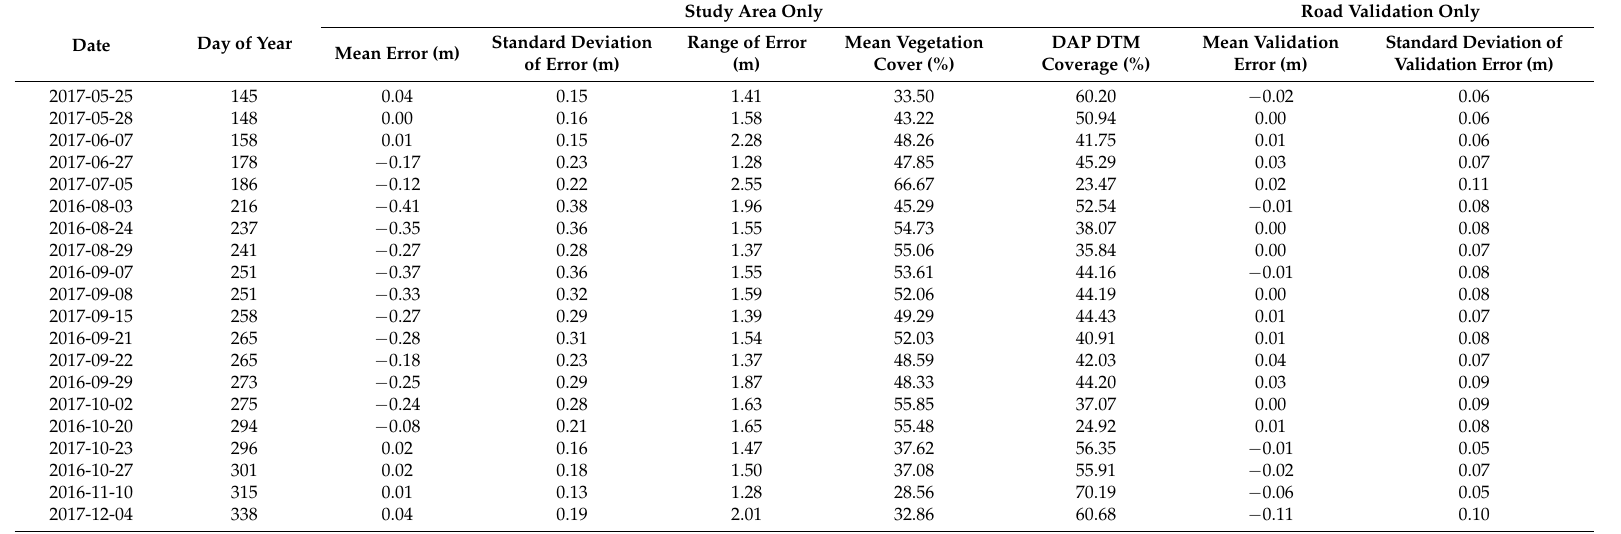
Table 2. Summary statistics of the differential error per flight for the entire study site, as well as only the road validation section of the analysis. DTM—digital terrain